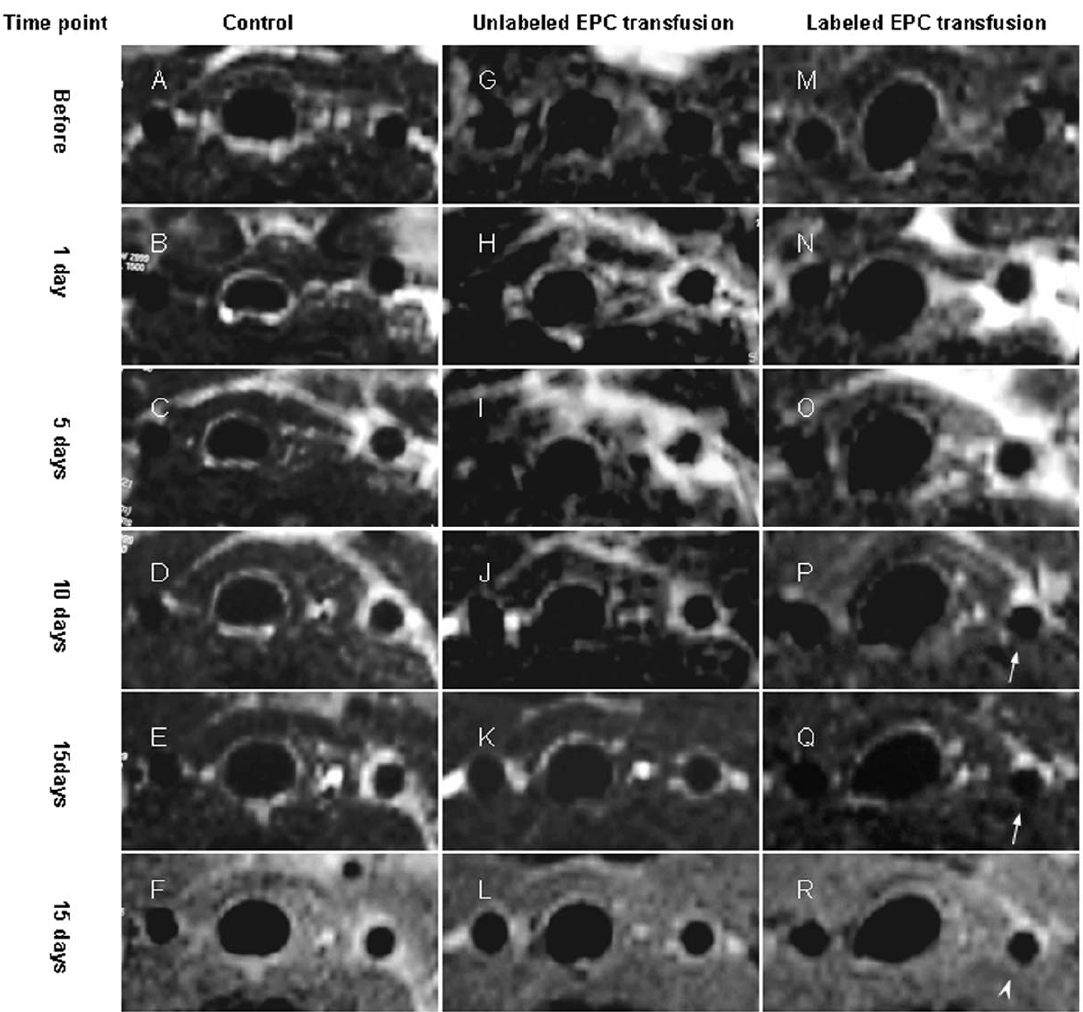
Figure 4. In vivo serial MR imaging. Figure 4A–4E, Figure 4G–4K and Figure 4M–4Q indicated T 2 WI. Figure 4F, 4L, and 4R indicated PDWI. Before artery injury, LCCA appeared normal on MR image without wall thickening and stenosis. After artery injury, wall thickening and stenosis of LCCA was obviously observed. Large MR signal voids of vessel wall was revealed on T 2 WI at 10 days and 15 days after artery injury (Arrow, Figure 4P, 4Q). However, the vessel wall was visible on PDWI (arrow head, Figure